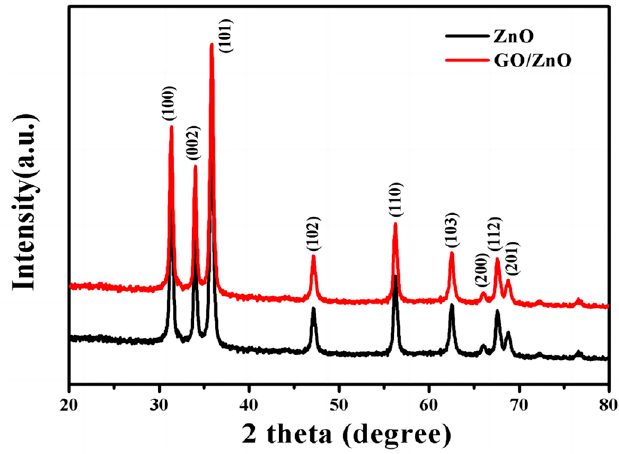
Figure 3. ( a , b ) TEM images of GO/ZnO nanosheets, ( c ) SAED pattern of the GO/ZnO nanosheets, ( d ) HRTEM image of GO/ZnO nanosheets.